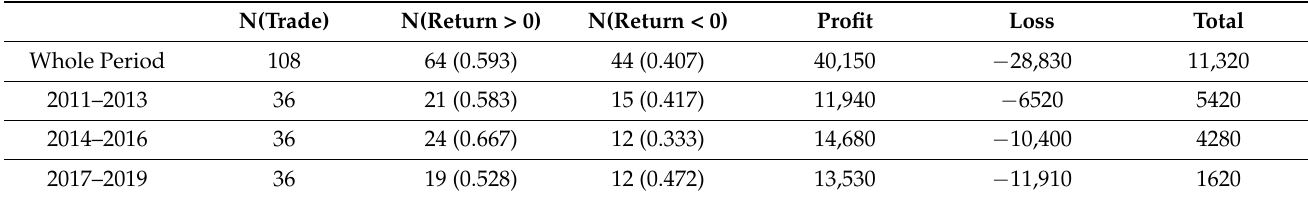
Table 12. The Performance of the Buy-and-hold Strategy.